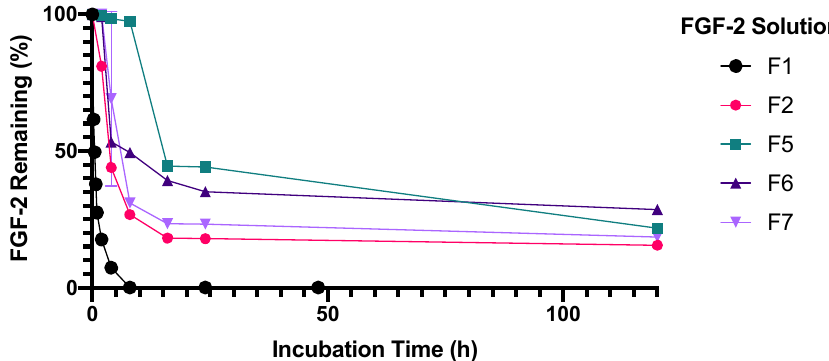
Figure 7. Effect of excipient combinations on the stability of FGF-2 aqueous solutions (770 ng/mL) incubated at 37 °C for up to 5 days. Residual FGF-2 content following incubation was measured by ELISA and expressed as a percentage of the baseline concentration (mean ± SD, n = 3). Abbreviation of samples: F1, FGF-2 in water; F2, FGF-2 and 0.05% w/v methylcellulose (MC) in water; F5, FGF-2, 0.05% w/v MC and 20 mM alanine in water; F6, FGF-2, 0.05% w/v MC and 1 mg/mL human serum albumin (HSA) in water; and F7, FGF-2, 0.05% w/v MC, 20 mM alanine and 1 mg/mL HSA in water.